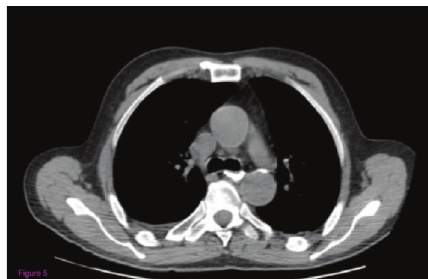
Figure 5: CT scan with gastrographin showing the contrast extrava-